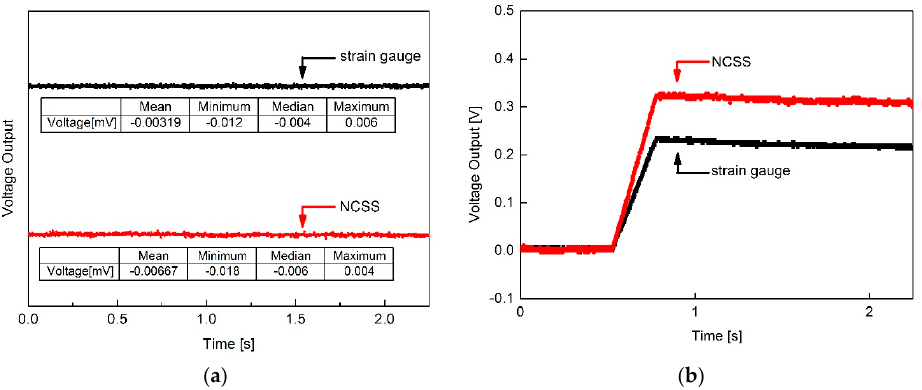
Figure 5. Response profiles of the MWCNT/epoxy nanocomposite strain sensor (NCSS) and strain gauge: ( a ) NCSS voltage output without a load; ( b ) NCSS voltage output under a static load (step response).